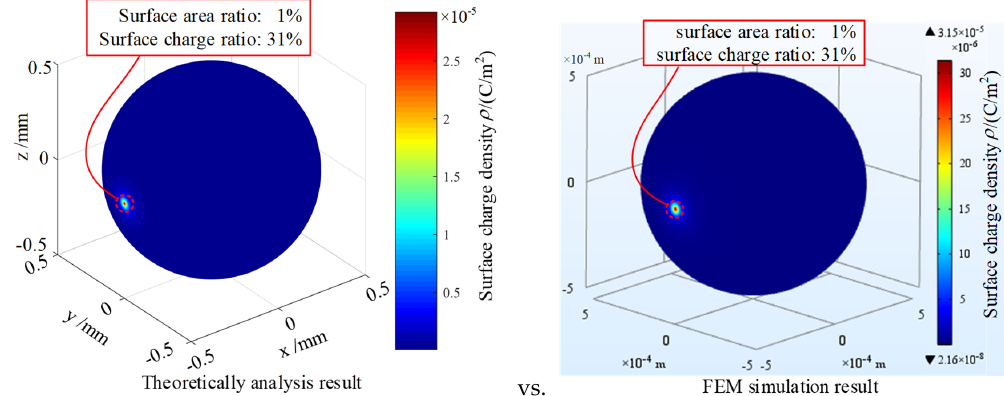
Figure 5. Modeling analysis and simulation results of surface charge distribution on the ϕ 1 mm probing ball.